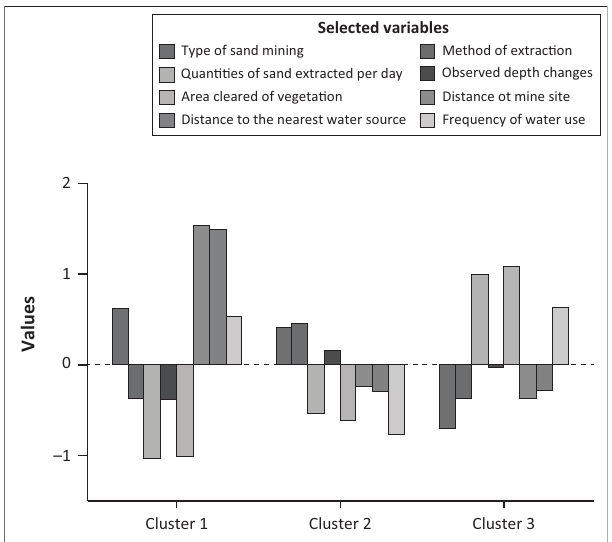
FIGURE 5: Sand mining clusters along the Njelele River.